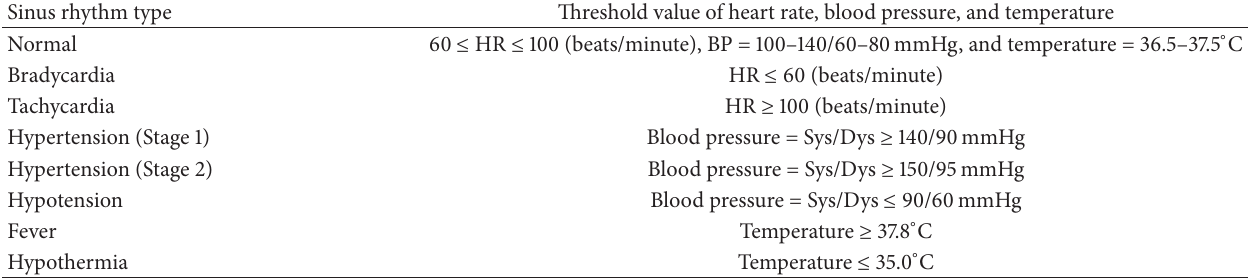
Table 1: Threshold values for alarming mechanism.